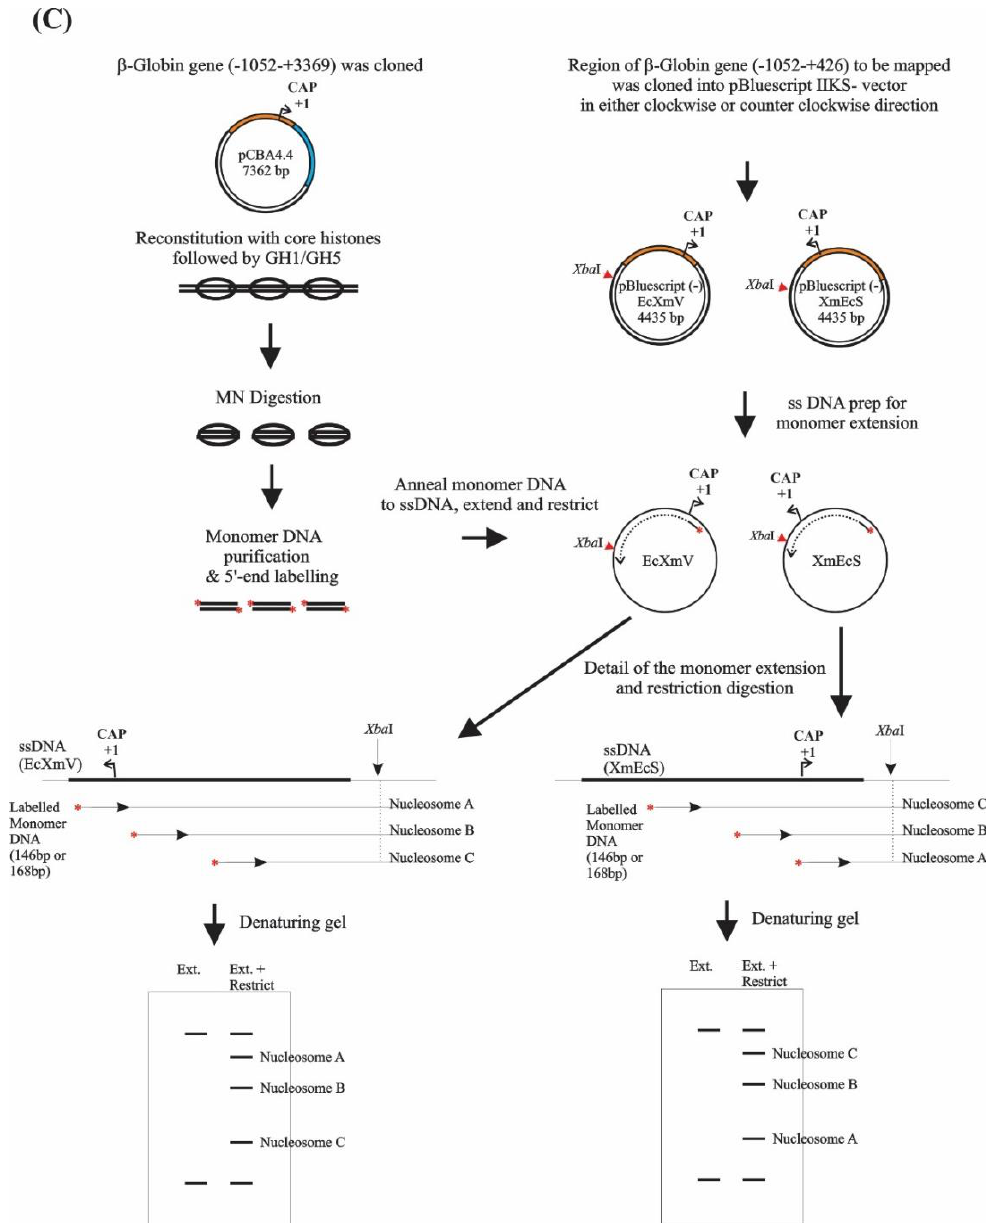
Figure 1. ( A ) Chromatosome protection of reconstituted chromatin containing no GH1/GH5 or equal molar ration of recombinant GH1 (+GH1) or GH5 (+GH5). DNA purified from MNase digested chromatin were run in a 6% polyacrylamide gel. The marker was an Msp I digest of pBR322 DNA. ( B ) A 6% denaturing polyacrylamide gel analysis of 5′ end labelled core particle and chromatosomal DNAs; 0GH147: core particle DNA derived from reconstitutes lacking linker histone globular domain. GH1-147 and GH5-147: core particle DNAs derived from GH1- and GH5-containing reconstitutes, respectively. GH1-167 and GH5-167: chromatosomal DNA derived from GH1- and GH5-containing reconstitutes, respectively. Markers: size standards included C and T sequencing reactions of M13mp18 DNA (Lc and Lt, respectively). ( C ) A schematic outline of the monomer extension and restriction procedures used to map nucleosome binding sites.